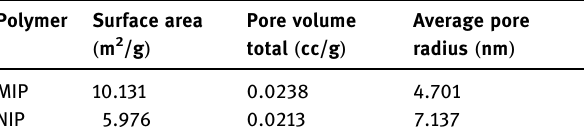
Table 3: BET result of MIP and NIP Polymer Surface area ( m 2 /g )